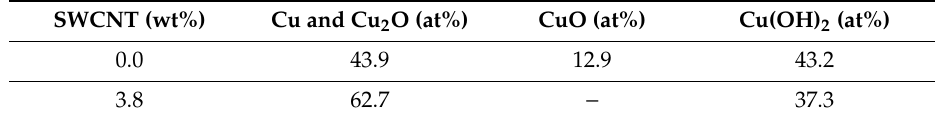
Figure 3. High resolution Cu 2p XPS showing the presence of copper oxidation states in ( a ) electrodeposited copper and ( b ) Cu–SWCNT composite deposited with 3.8 wt% SWCNTs in CuSO 4 (0.1 M) solution at a bath temperature of 60 °C. Table 3. Chemical composition of copper estimated from the relative areas of components within the Cu 2p XPS spectra of Cu–SWCNT composites electrodeposited at a bath temperature of 60 °C. 1 .